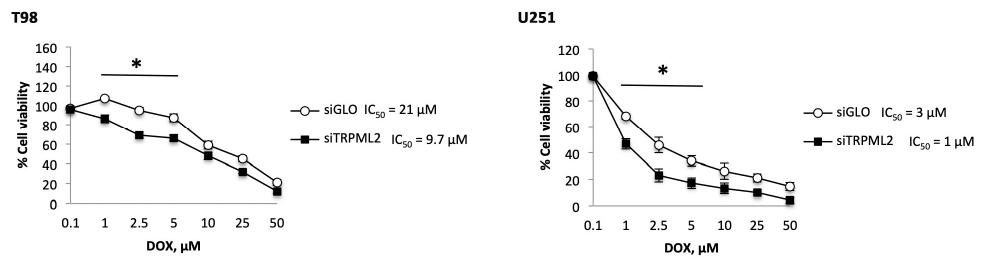
Figure 5. TRPML2 silencing affects the DOX resistance in T98 and U251 cell lines. Cell cytotoxicity was evaluated by 3-(4,5-dimethylthiazol-2-yl)-2,5-diphenyltetrazolium bromide (MTT) assay in siGLO and in siTRPML2 T98 and U251 cell lines, treated with DOX at different doses for 24 h. Data shown are expressed as the mean ± SE of three separate experiments. * p < 0.05 siTRPML2 vs. siGLO. In addition, treatment of T98 and U251 cells with the TRPML2 agonist, ML2-SA1, at 10 μ M, increased the resistance to DOX-induced cytotoxic effects in both cell lines (vehicle- vs. ML2-SA1-treated T98 cells, IC50 = 47.0 vs. 95.0 µ M; vehicle- vs. ML2-SA1-treated U251 cells, IC50 = 3.5 µ M vs. 5.6 µ M) (Figure 6).